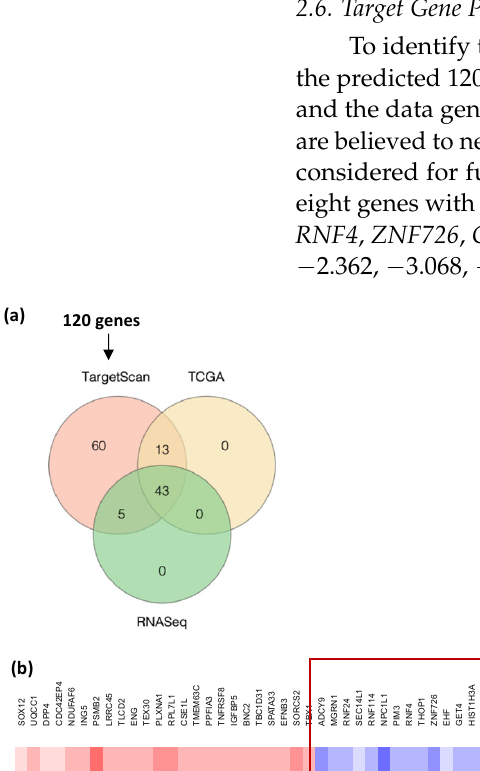
H3C1ADCY9EHFGET4MGRN1NPC1L1PIM3RNF114RNF4SEC14L1THOP1ZNF726RNF24H2BC5 G Expression of 14 Dow nregulated G enes in TCG A Data